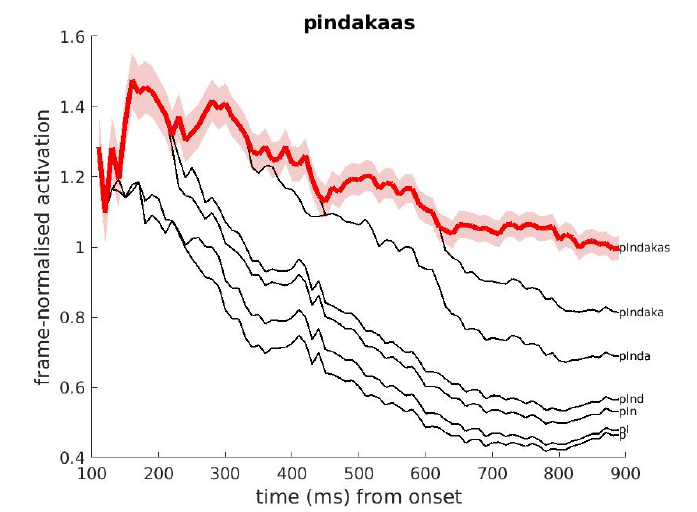
Figure 5. Example of DIANA’s activation over time corresponding to the Dutch word ‘pindakaas’ (SAMPA /pIndakas/; Eng. ’ peanut butter ’). The pink band around the red line indicates the p = 0.05 confidence